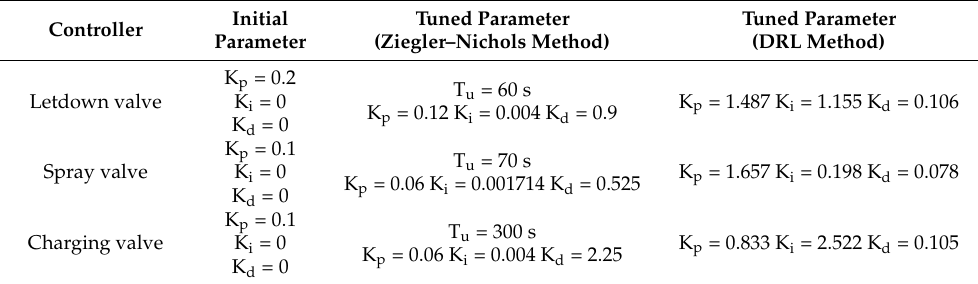
Table 6. Tuning results based on Ziegler–Nichols method and DRL tuning